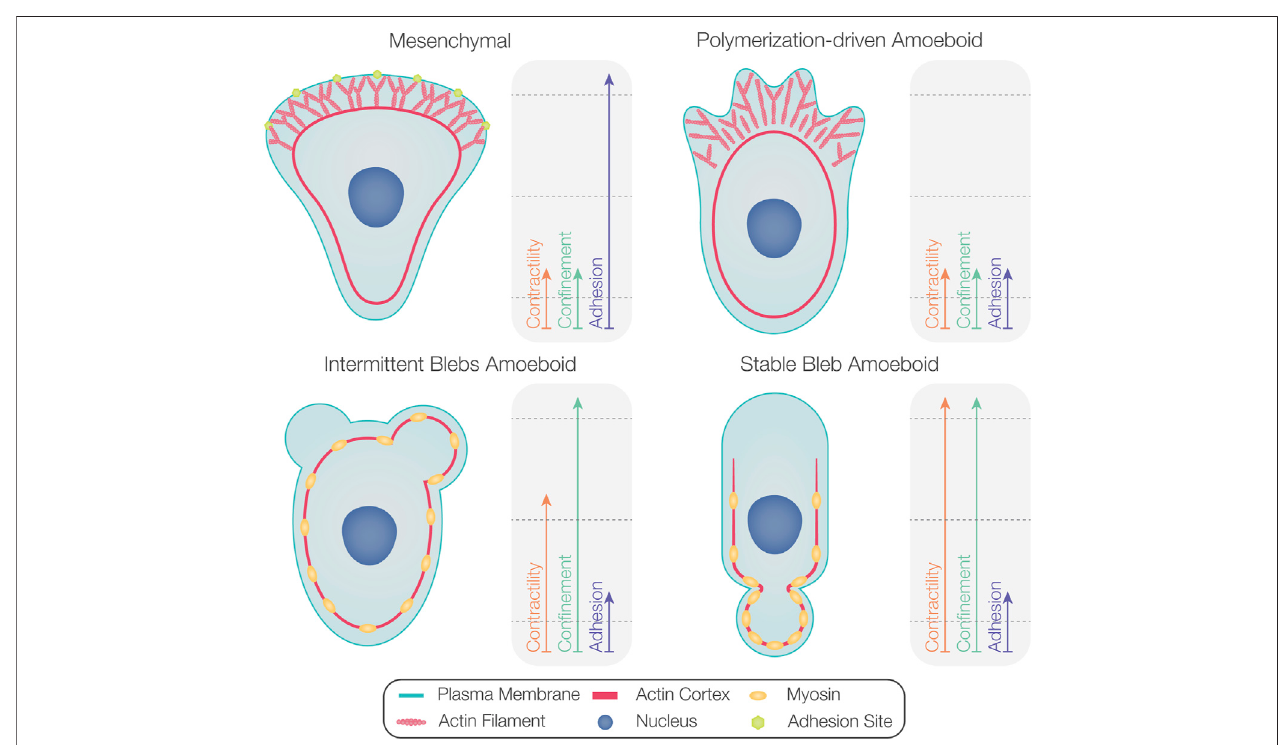
FIGURE 4 | Factors determining the degree of bleb formation in migrating cells. While mesenchymal motility is associated with high levels of substrate adhesion (upper left), polymerization-driven amoeboid motility occurs at lower levels of substrate adhesion (upper right). As the contractility level increases, amoeboid-motile cells form more blebs than polymerization-driven protrusions(bottom left). Cells displayingnon-persistent bleb-based motility can switch tostablebleb migration at veryhigh contractility levels (bottom right). Con fi nement can also promote blebbing activity.